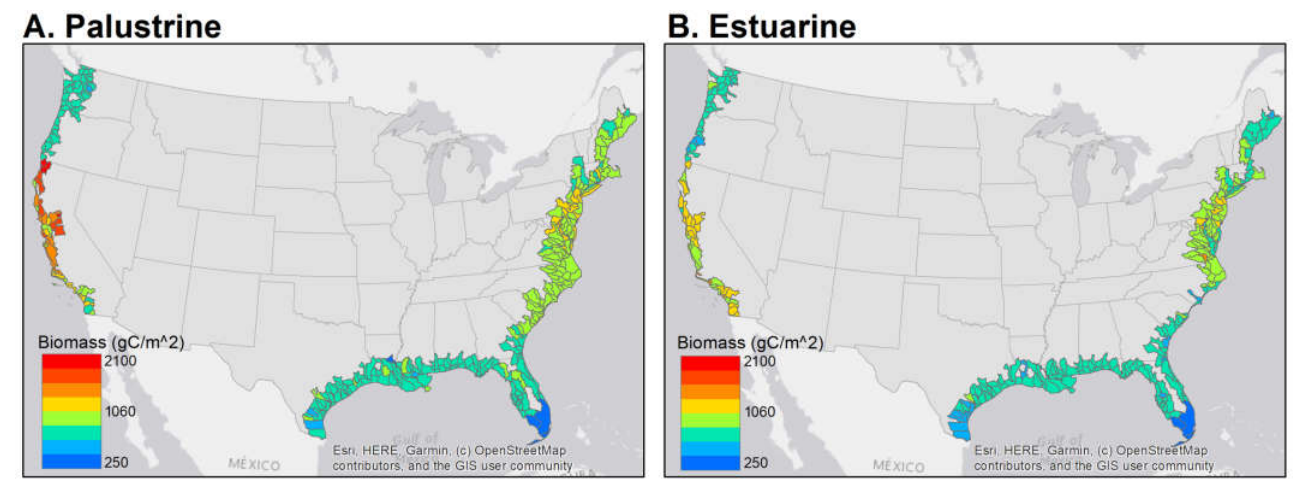
Figure 3. Peak total (above- and belowground) biomass carbon in palustrine and estuarine herbaceous wetlands by hydrologic unit.